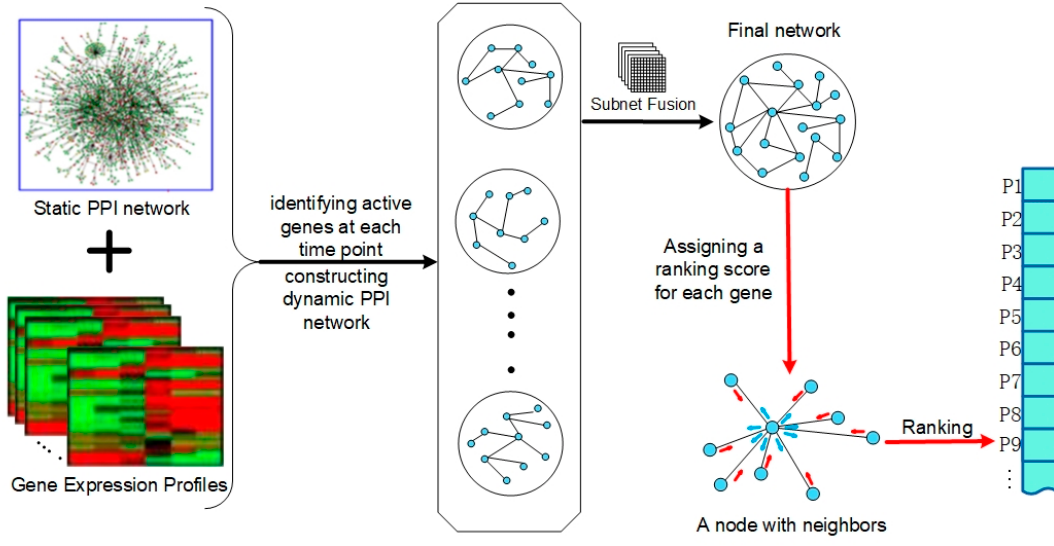
Figure 1. The workflow of our method.